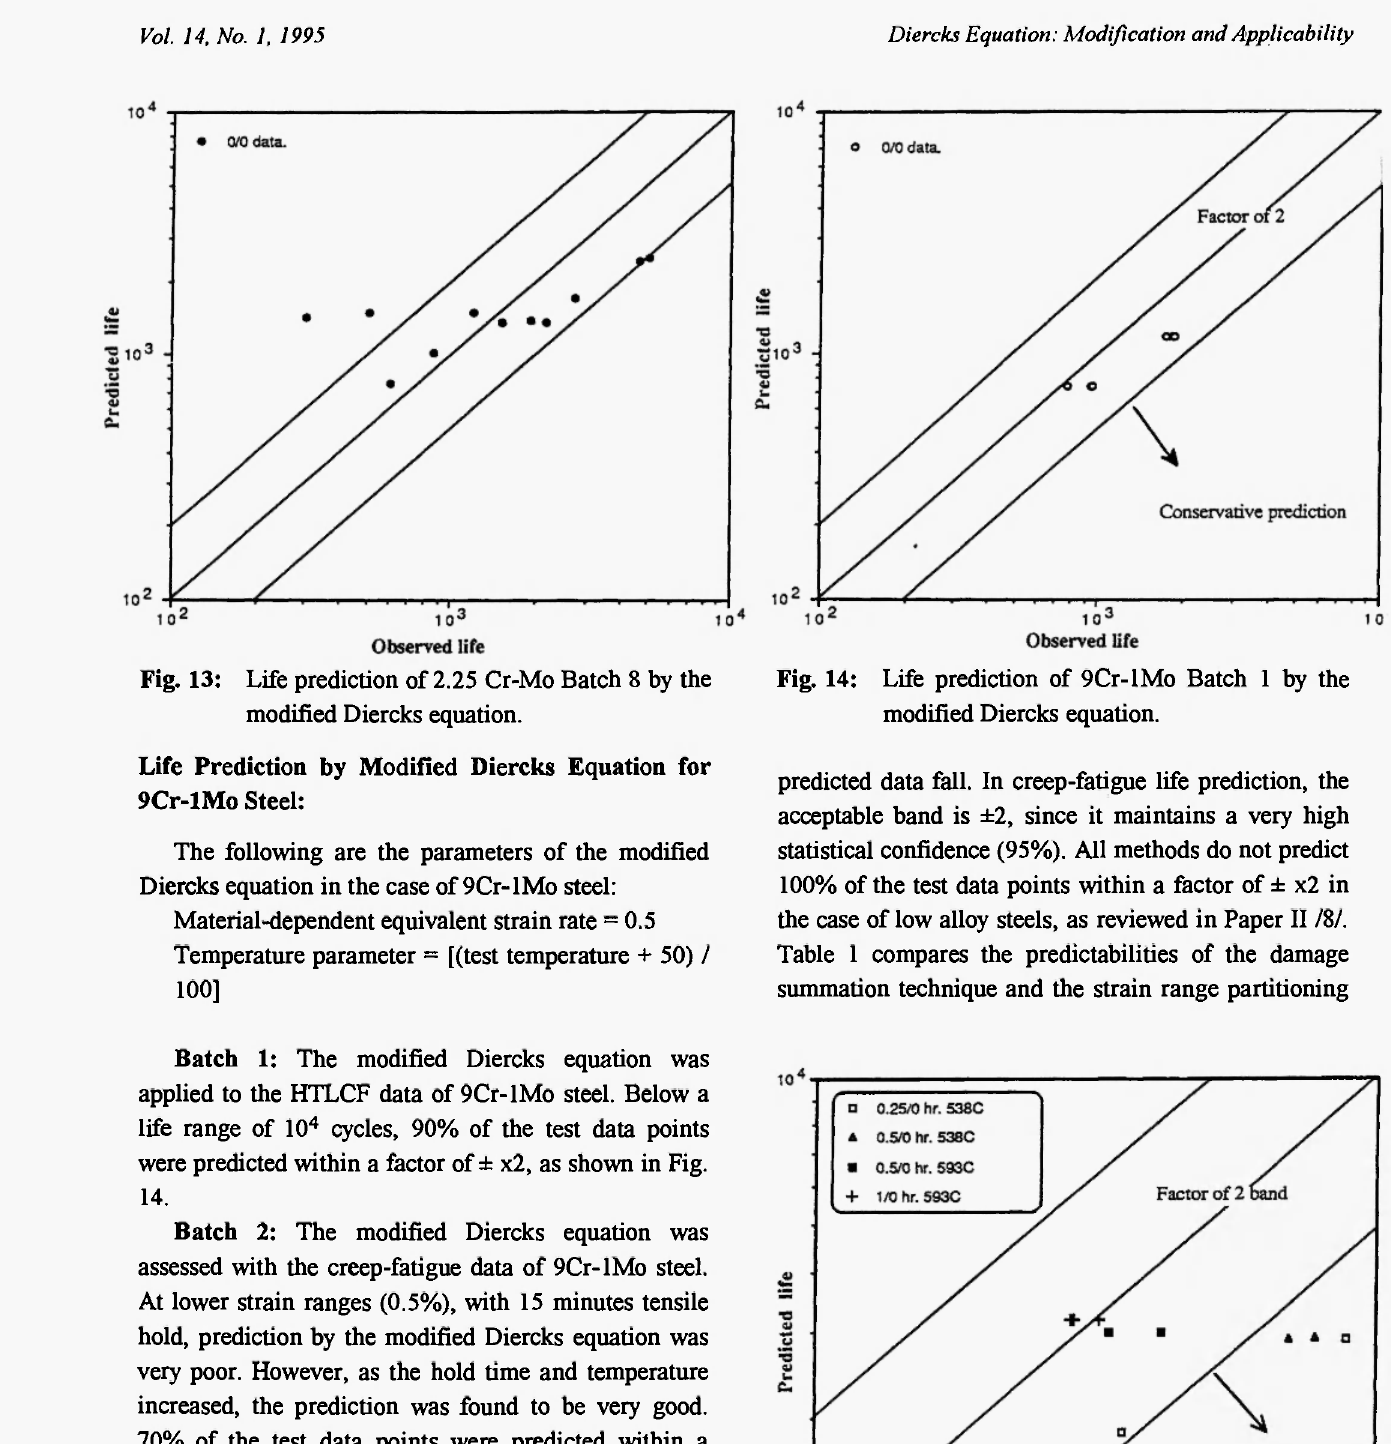
Fig. 14: Life prediction of 9Cr-lMo Batch 1 by the modified Diercks equation.